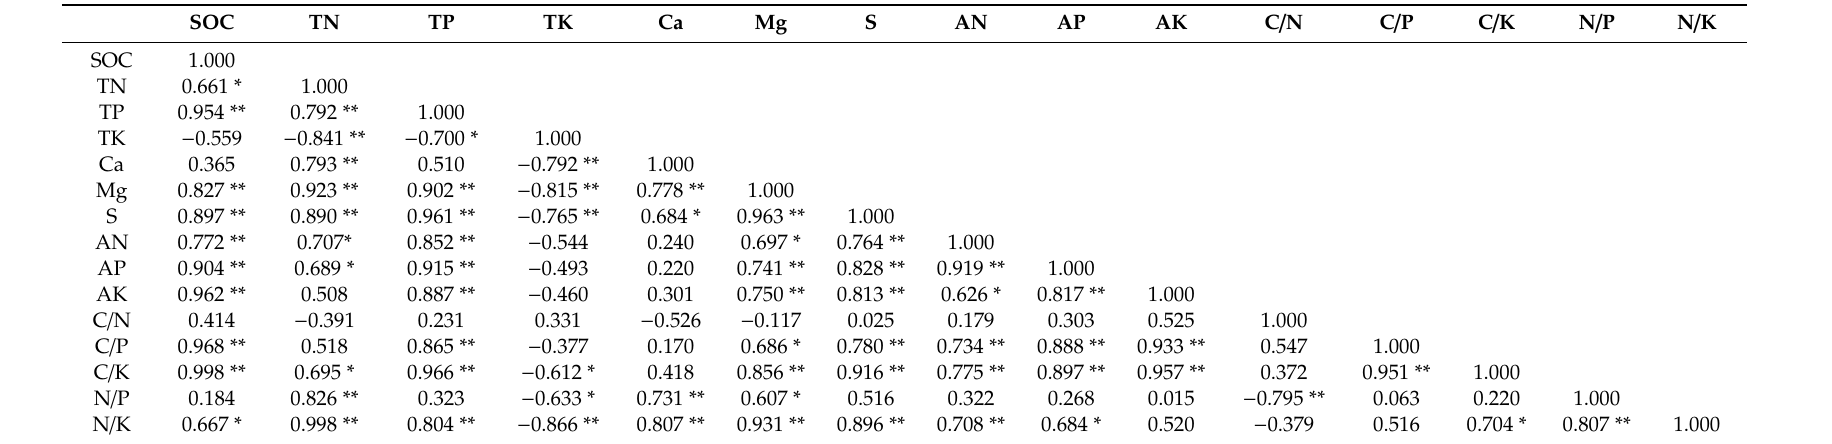
Table 1. Correlation matrix for the soil nutrient contents and their stoichiometric